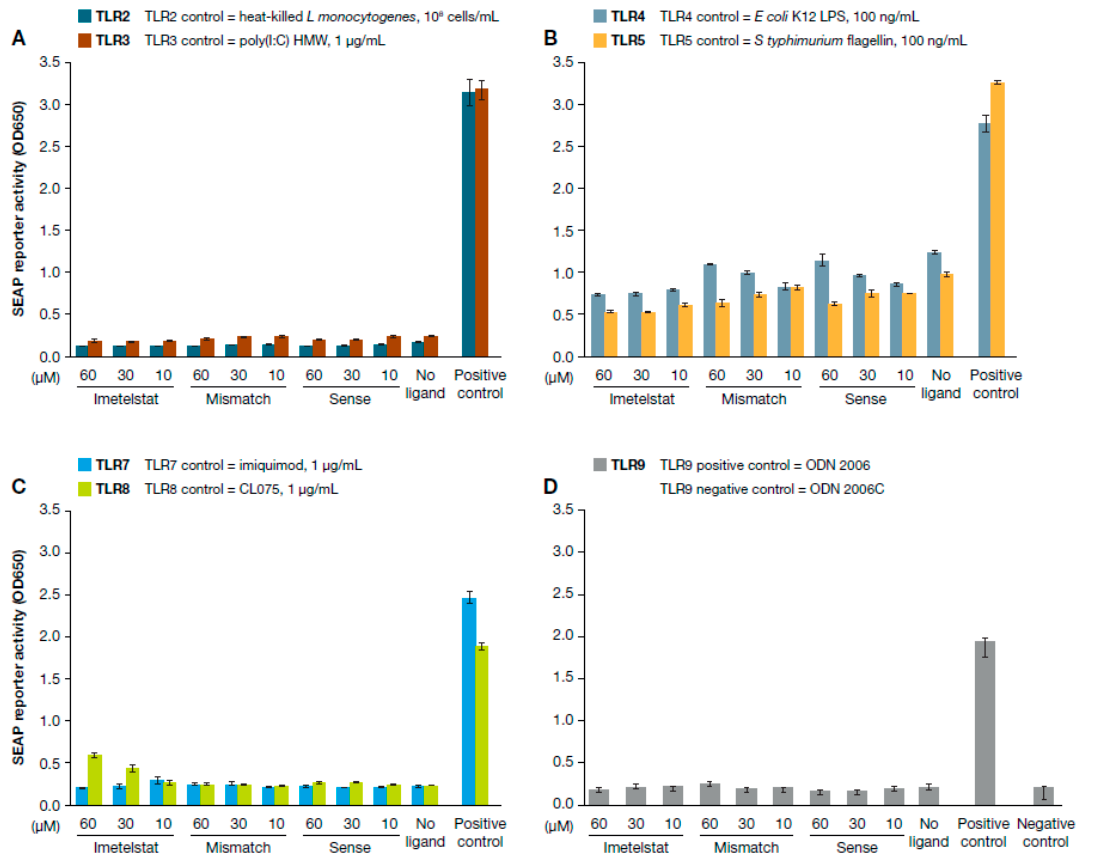
Figure 1. Effects of imetelstat on TLR activity as measured by NF κ B-inducible secreted embryonic alkaline phosphatase (SEAP) reporter assay. HEK-Blue TLR cells were incubated with different positive control ligands or three concentrations of imetelstat. After 20 h incubation, the cells were measured for absorbance at 650 nm for SEAP activity. Each TLR experiment was performed twice with three replicates per experiment. Mean values with standard derivations are shown. Effects of imetelstat on ( A ) TLR2 and TLR3 receptors; ( B ) TLR4 and TLR5 receptors; ( C ) TLR7 and TLR8 receptors; and ( D ) TLR9 receptors.